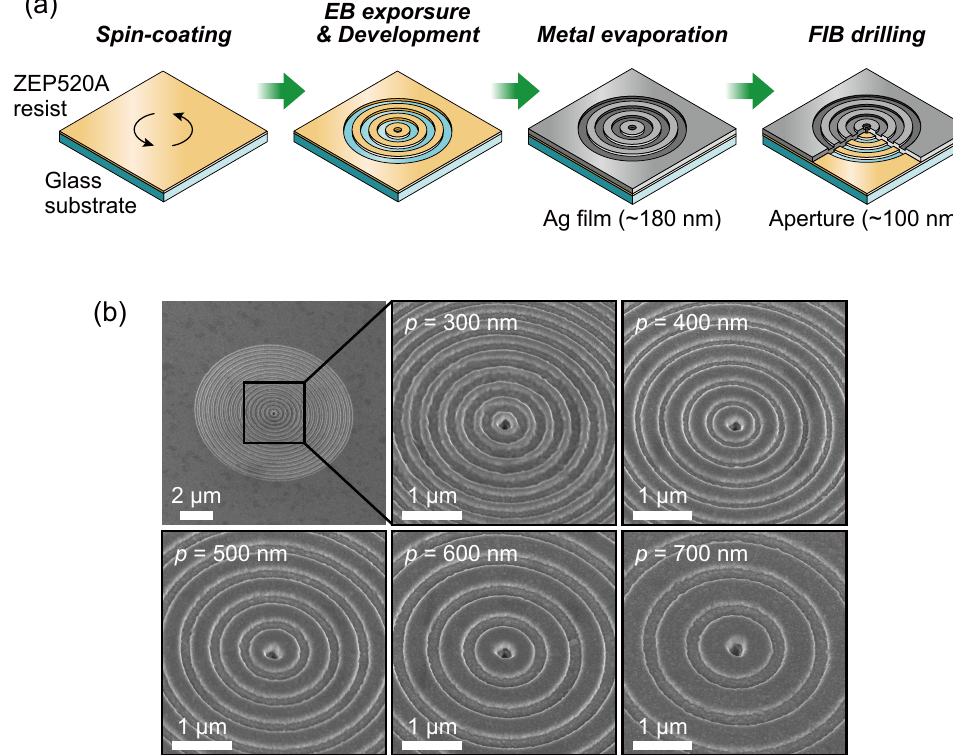
Figure 4. ( a ) The fabrication process for the periodic concentric corrugated plasmonic film. ( b ) The tilt SEM images of the fabricated structures with a corrugation period of 300–700